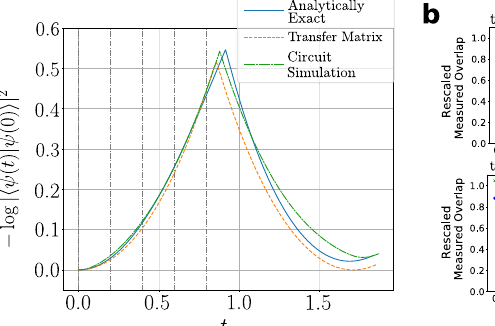
Fig. 5 | Time-evolution results. a Dynamical Quantum Phase Transition in the Quantum Ising Model: The dynamics of the transverse fi eld Ising model can be obtained analytically and form a good basis for the comparison with our quantum circuits. These are shown in blue and compared with dynamics obtained from numerically exact optimisation of the principal eigenvalue of the transfer matrix within our ansatz shown in orange, and the numerical optimisation of the circuits shown in Fig. 4 in the absence of noise shown in green. The results show that the circuitcostfunctioncanfaithfullytrackthedynamics. b Cost-functionevaluatedon